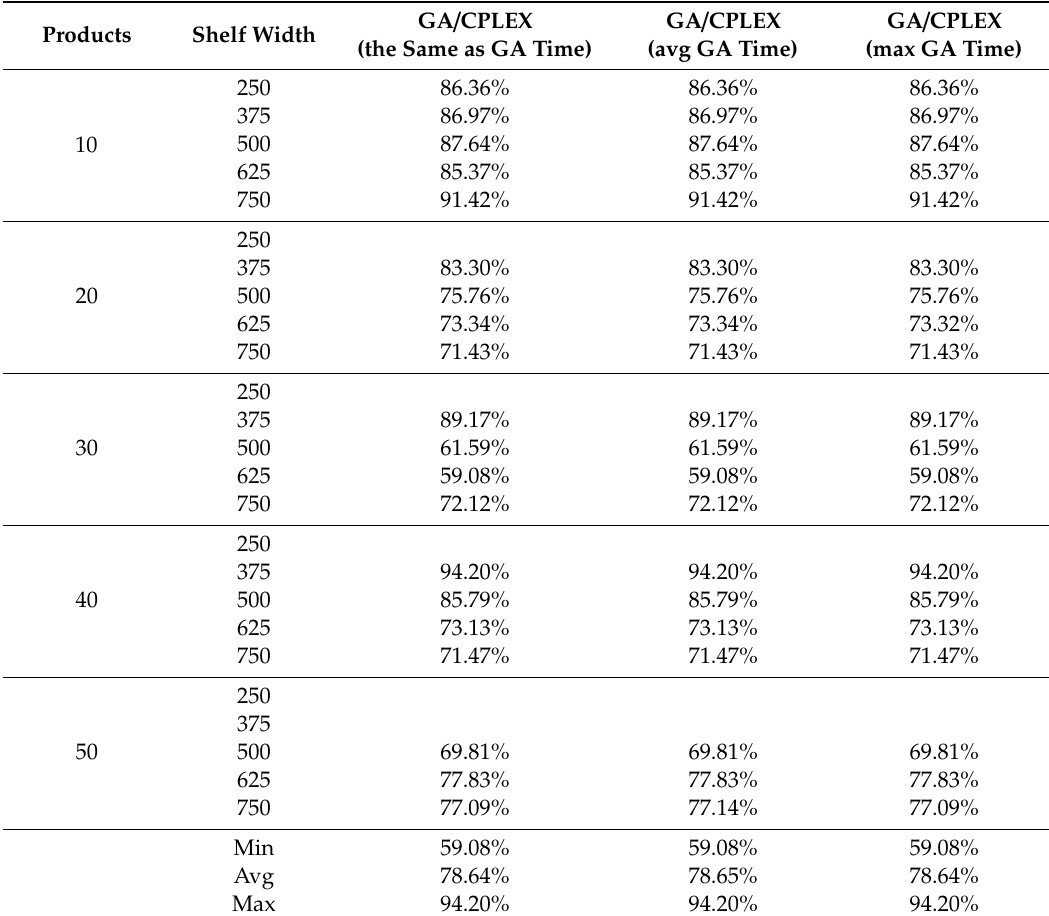
Table 4. Quality of the best genetic algorithm (GA) solution compared with the CPLEX solution.